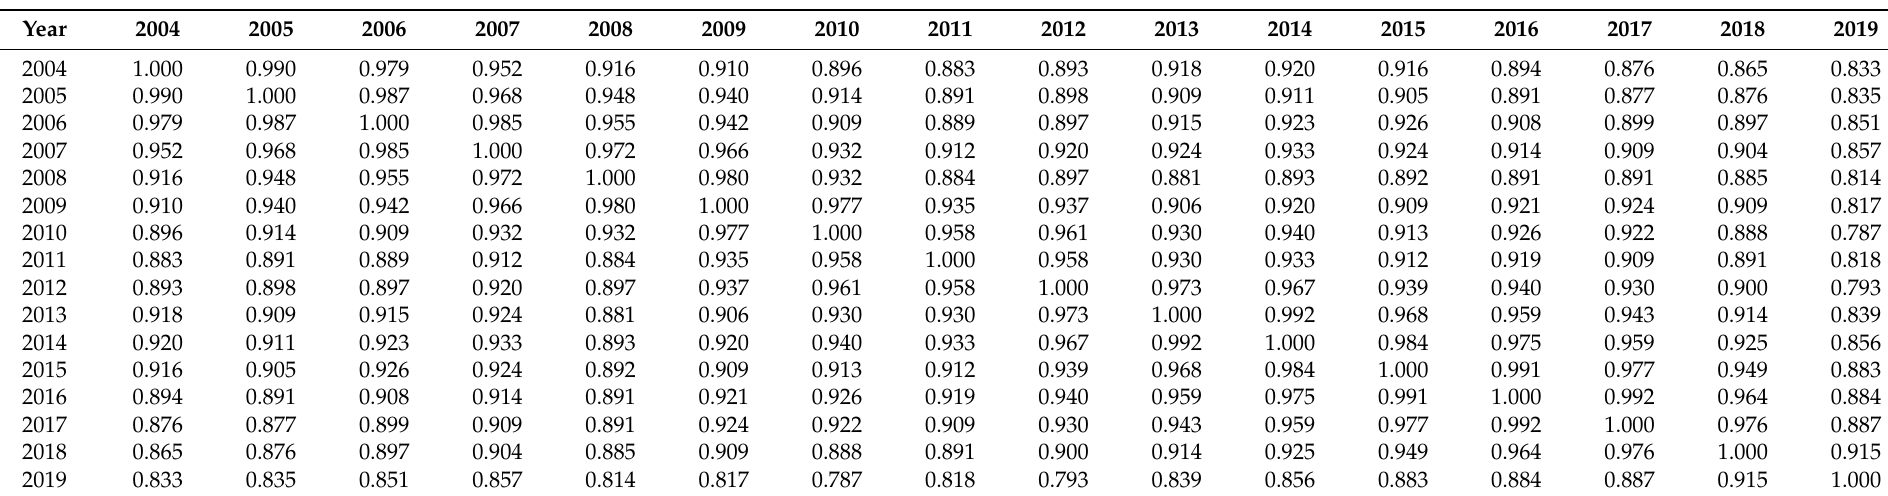
Table A3. The τ -Kendall’s correlation coefficients calculated for EU countries ranks according to taxonomic measure of